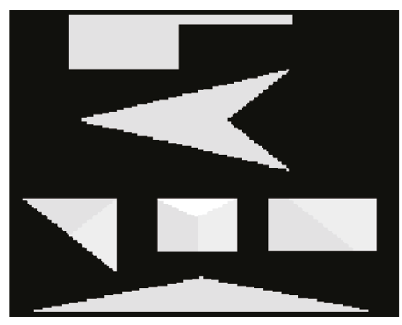
Figure 4: A synthetic